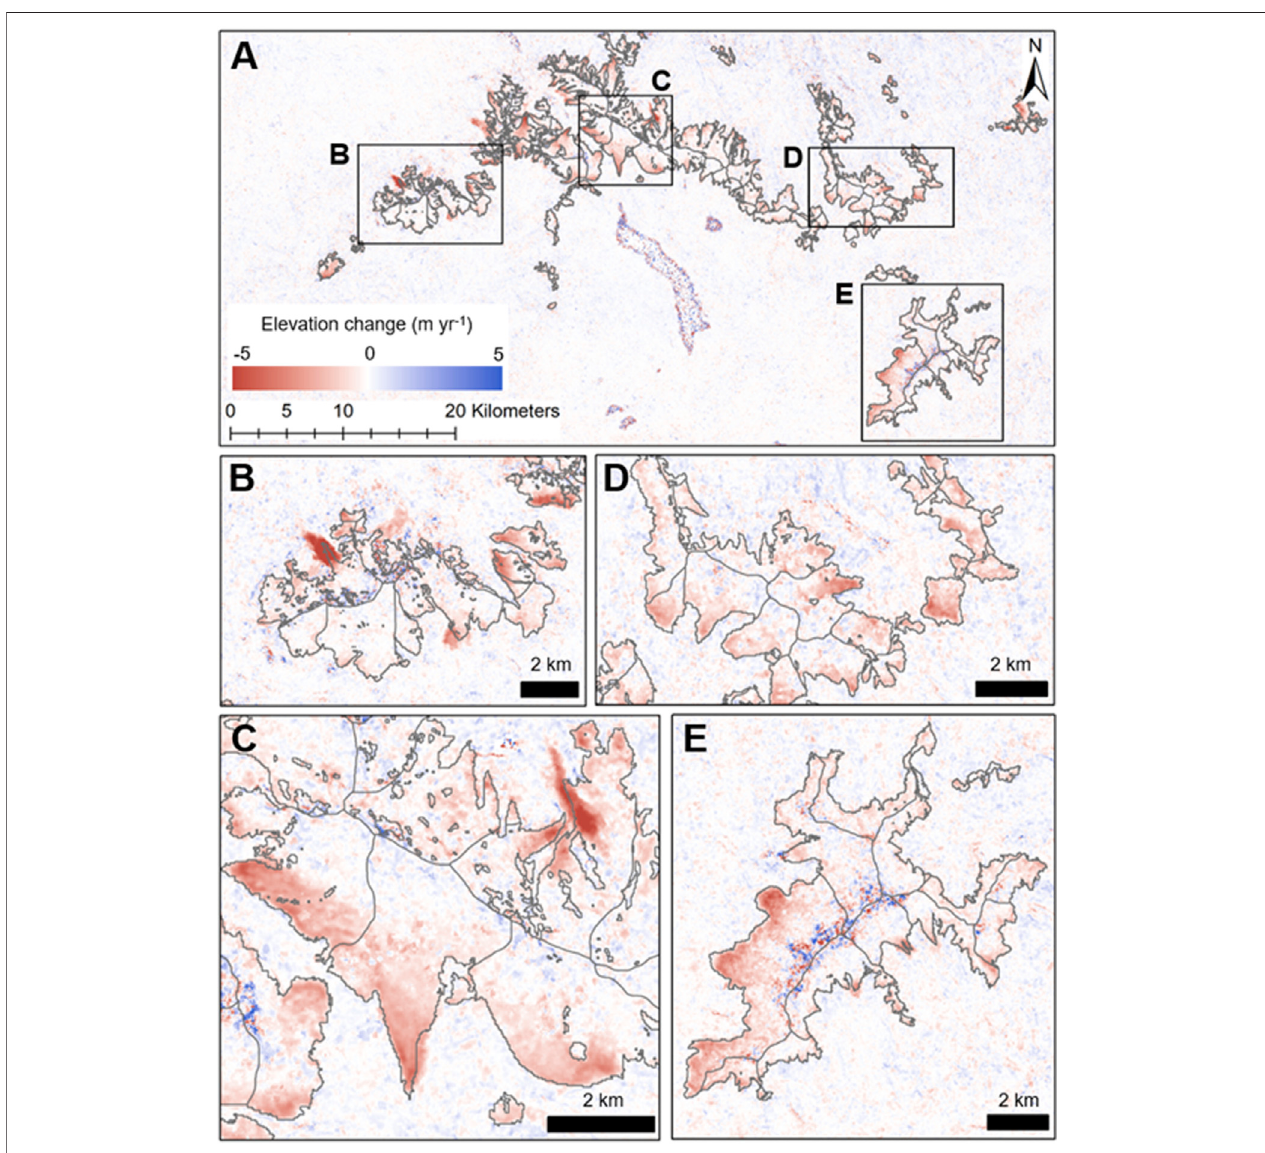
FIGURE4| Elevation change from2000to2020over thecentral range oftheCordilleraVilcanota. (A) Overview ofelevation changein theCordillera Vilcanota. The large pixelated body in the centre of the fi gure is Laguna Sibinacocha. (B) Nevado Ausangate. (C) Chumpe Glacier. (D) Cluster of lower-lying Eastern glaciers. (E) Quelccaya ice cap. Glacier outlines from the year 2000 are in light grey. Large surface elevation changes in off-ice areas most notably in (B,C) are from debris- covered ice.